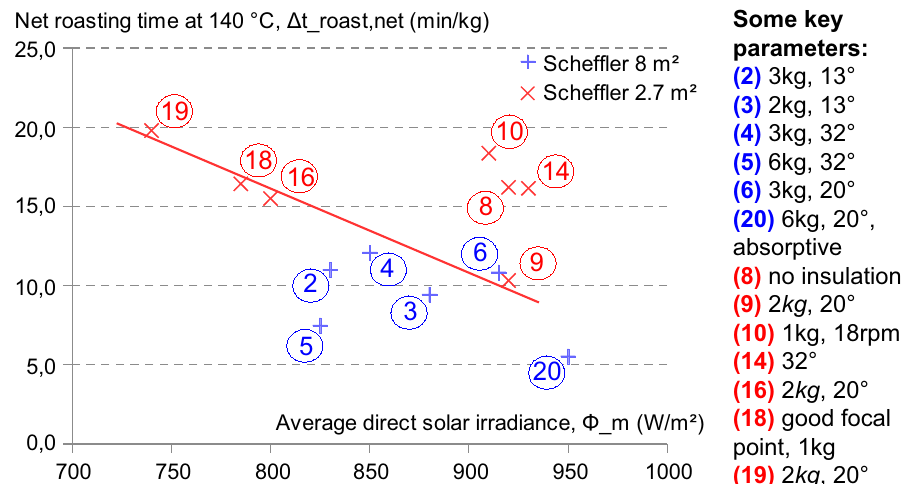
Fig. 3. Comparison of experiments: net roasting time at 140 ° C per kilogram of cacao versus direct solar